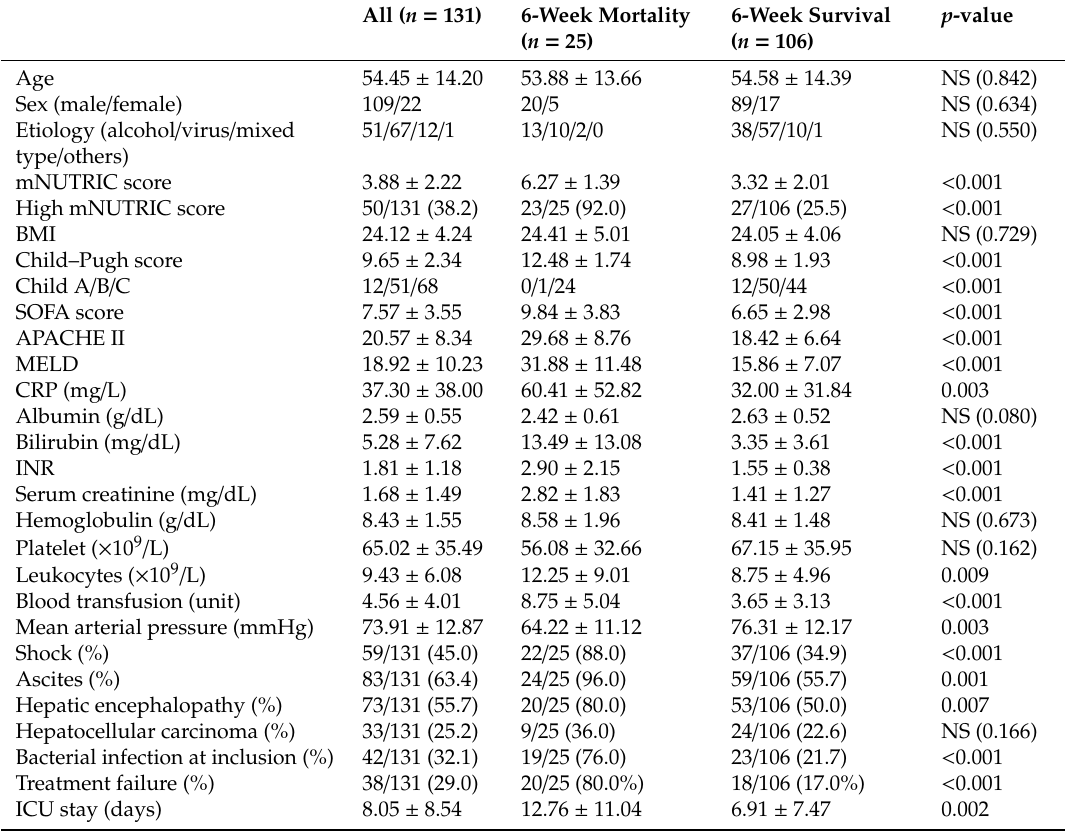
Table 1. Patients’ demographic data and clinical characteristics grouped according to 6-week mortality.